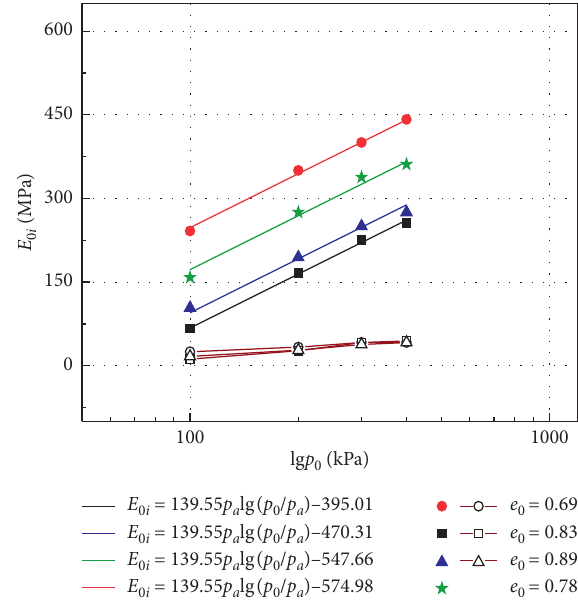
Figure 16: Relationship between E